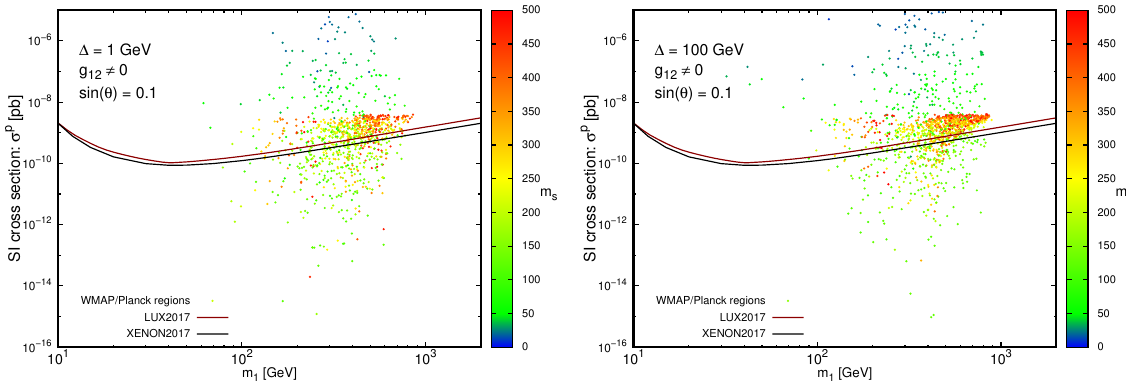
Figure 9 . The DM-proton (SI) scattering cross section as a function of DM mass for the mass split- ting (cid:1) = 1 GeV (left) and (cid:1) = 100 GeV (right) . The singlet scalar mass is 10 GeV < m s < 500 GeV and the mixing angle is sin (cid:18) = 0 : 1. The couplings are chosen as (cid:0) 1 < g 1 ; g 2 ; g 12 < 1.